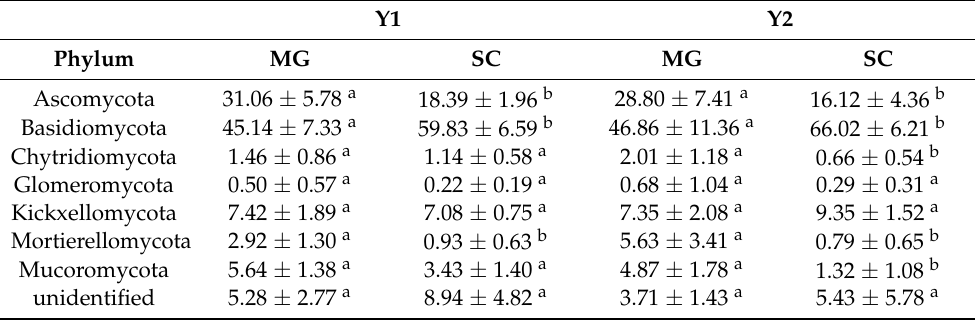
Table 1. Taxonomic distribution, at phylum level, of operational taxonomic units (OTUs) retrieved from the two sampled sites (Morgex: MG; Saint Christophe: SC) at Y1 (year 1) and Y2 (year 2). Data are expressed as percentage (mean ± standard deviation). Different letters indicate significant differences (Anova; Mann-Whitney pairwise comparison; Bonferroni corrected p values; p < 0.05). Y1 Y2 Phylum MG SC MG SC Ascomycota 31.06 ± 5.78 a 18.39 ± 1.96 b 28.80 ± 7.41 a 16.12 ± 4.36 b Basidiomycota 45.14 ± 7.33 a 59.83 ± 6.59 b 46.86 ± 11.36 a 66.02 ± 6.21 b Chytridiomycota 1.46 ± 0.86 a 1.14 ± 0.58 a 0.66 ± 0.54 b Glomeromycota 0.50 ± 0.57 a Kickxellomycota 7.42 ± 1.89 a Mortierellomycota 2.92 ± 1.30 a Mucoromycota unidentified 5.28 ± 2.77 a 5.43 ± 5.78